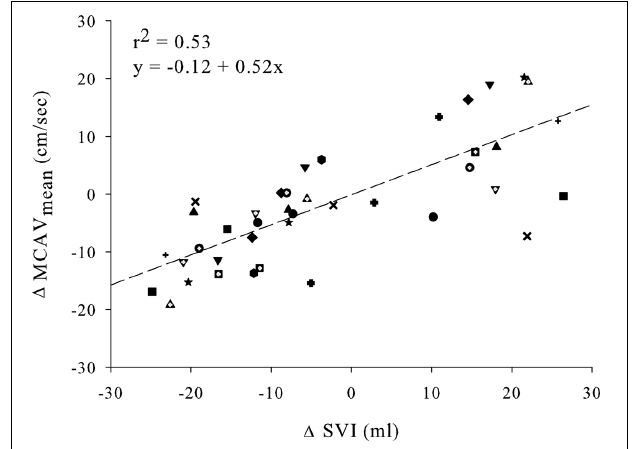
FIGURE 4 | Linear regression plot of absolute change in MCAV mean and SVI. All subjects contributed three points in each regression line (during 30 and 70 degrees + 0 degrees after tilt back). The regression function is equal to y = − 0 . 12 + 0 . 52 x with corresponding correlation coefficient of